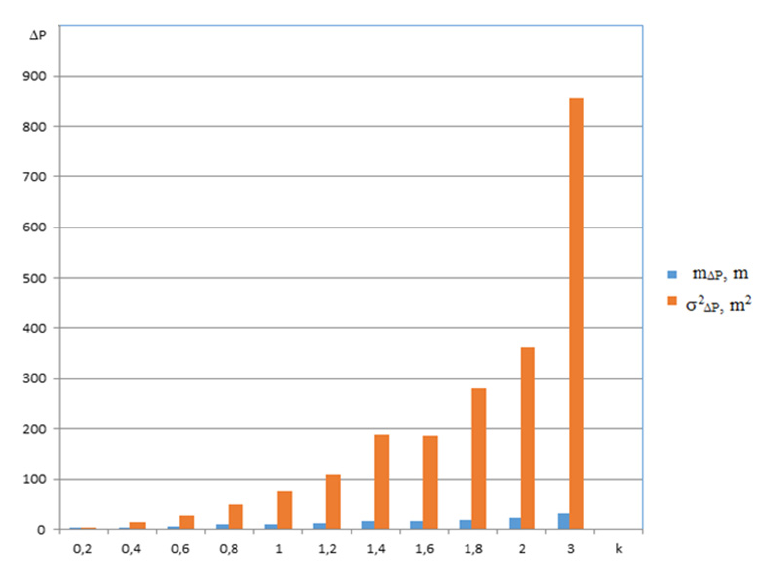
Figure 8. Accuracy of ACS positioning accuracy for maneuvered flight.